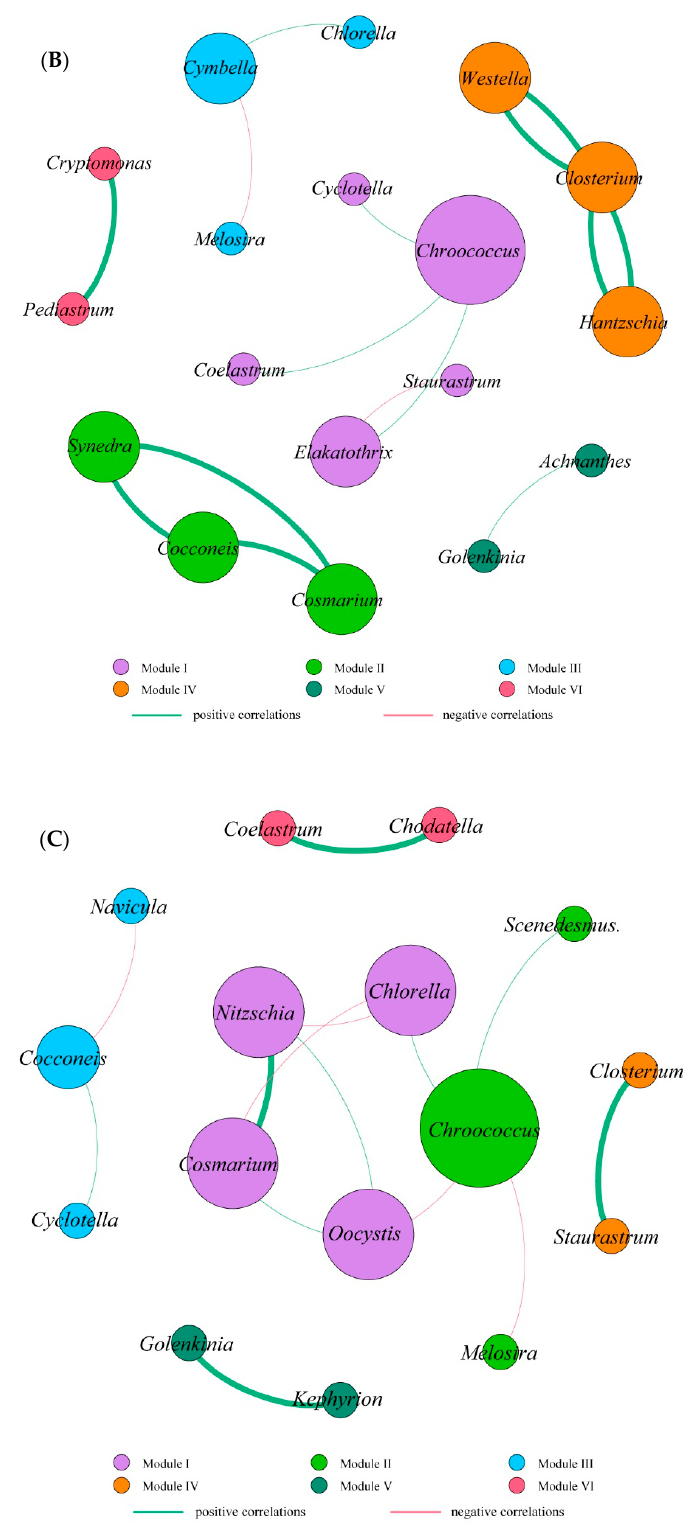
Figure 4. Network of co-occurring phytoplankton communities at the genus level based on a Spearman’s correlation significant analysis ( p < 0.01) from October to December in 2018. ( A – C ) represents the October, November, and December sampling times, respectively. The nodes were colored according to their modularity class. Each node represents one individual algal species. The larger the node is, the more connections it has to other nodes. The green lines signify positive correlations, while the red lines signify negative